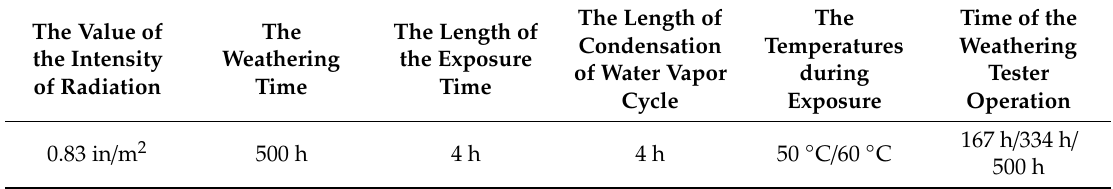
Table 2. Research assumptions of accelerated UV-A weathering.